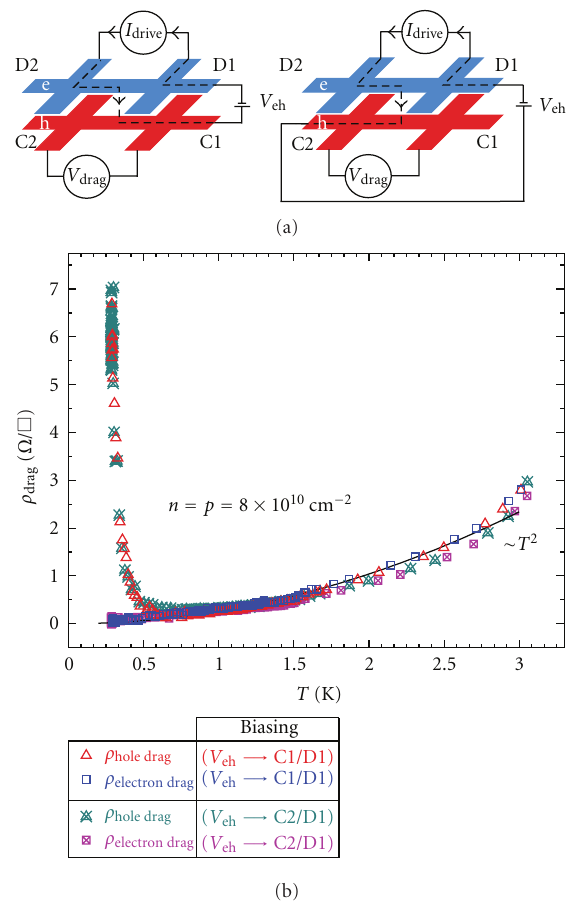
Figure 16: (a) Diagram showing that a sign reversal of the error in drag due to the excitation current leaking between layers is expected when biasing points (named C1, C2, D1, and D2) are altered, as the leakage current direction in the drag layer is changed. (b) Electron and hole drags for the two interlayer biasing configurations, for n = p = 8 × 10 10 cm − 2 . (Device: B138/C4-2-10nm Barrier).